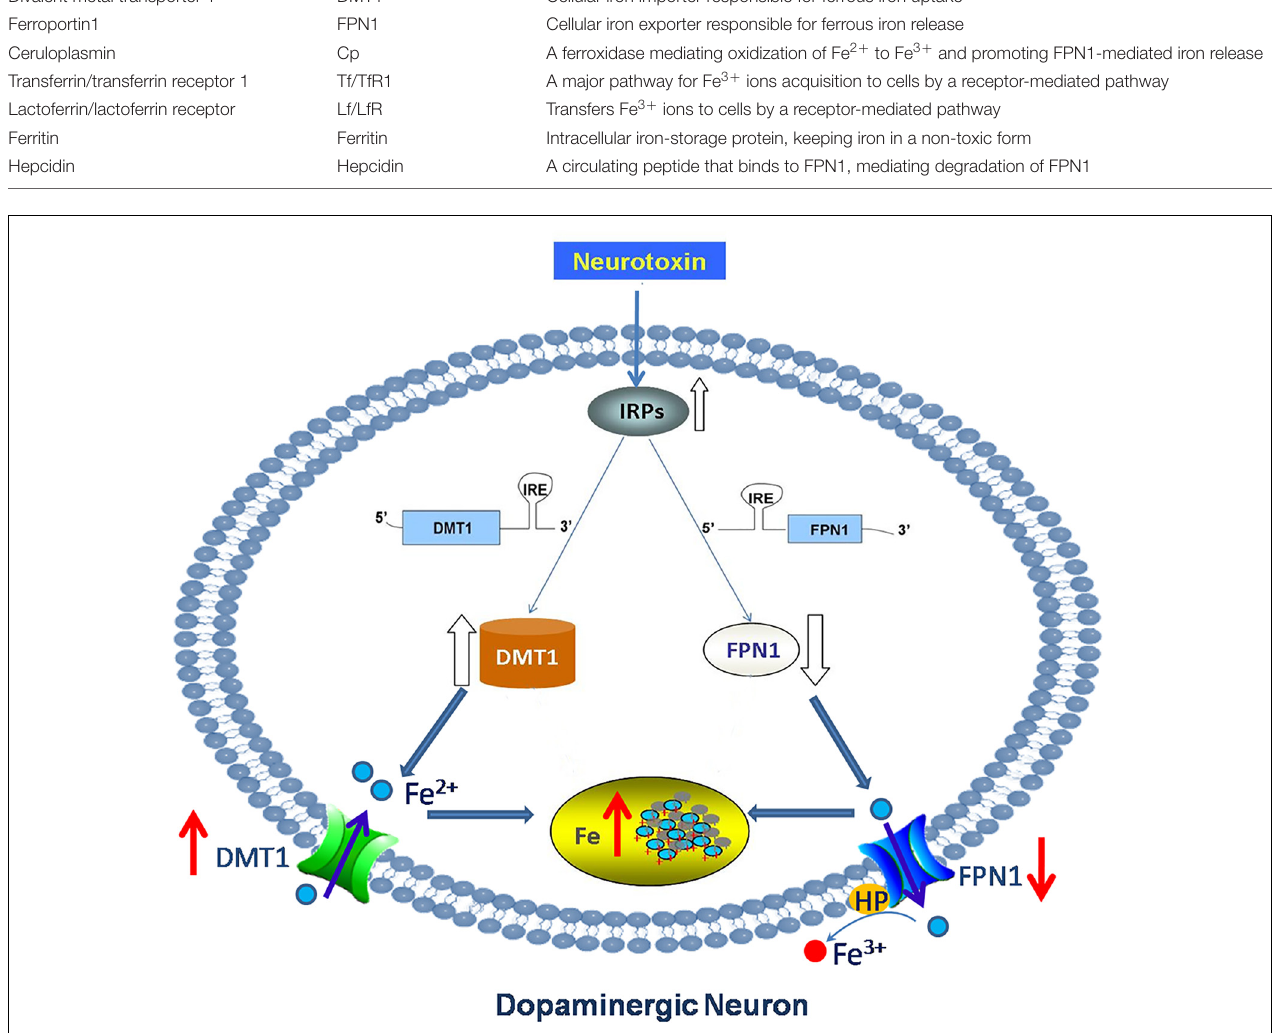
FIGURE 1 | Abnormal expression of iron transporters caused iron accumulation in DA neurons in PD. Neurotoxin induced up-regulation of iron importer DMT1 and down-regulation of iron export protein FPN1 in PD via activation of IRPs. This abnormal expression of iron transporters caused iron accumulation and enhanced iron-induced neurotoxicity in dopaminergic neurons in